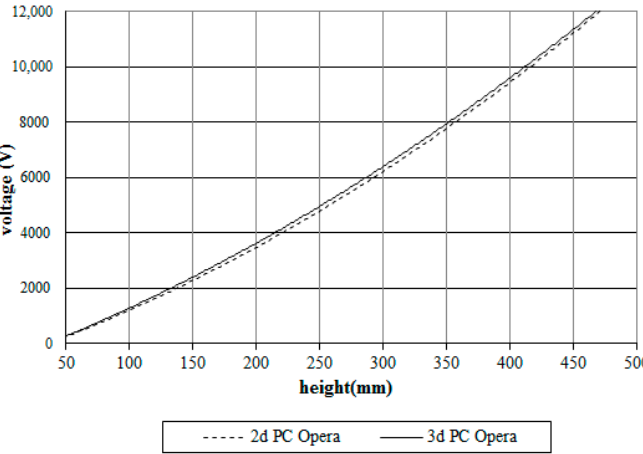
Figure 4. Comparison of the voltage distribution along varistor using 2D and 3D PC Opera.